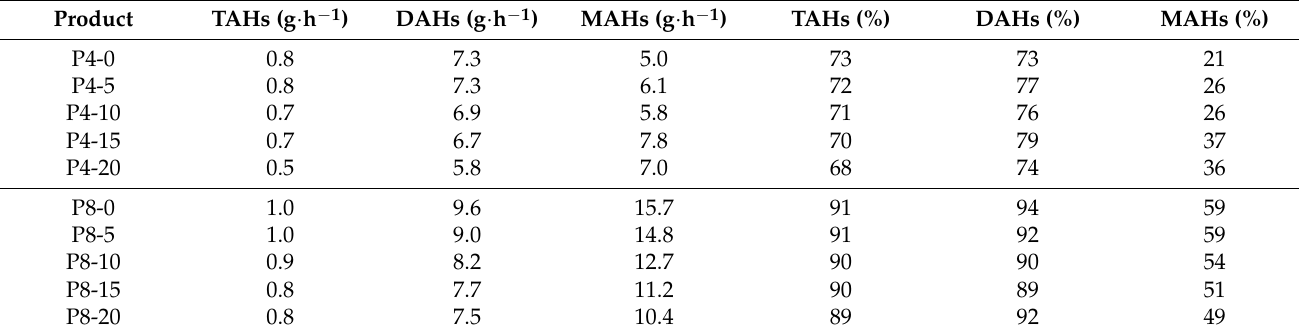
Table 8. Total amount of TAHs, DAHs and MAHs removed in each experiment and the relative removal of each type of aromatics.